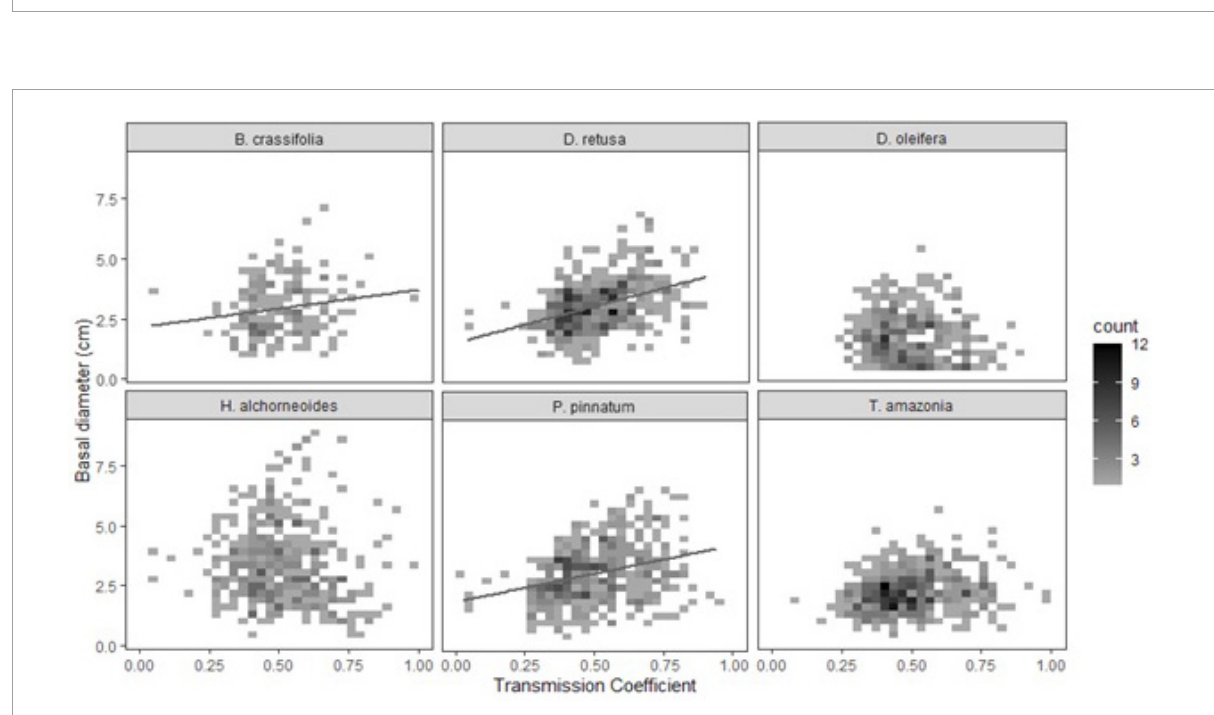
FIGURE3 Effect of crowding pressure from teak on seedling growth (30-month basal diameter, cm) for each of the six enrichment planting species. Basal diameter values are plot-level means ( n = 12 seedlings). Crowding pressure values are for one target seedling per plot. There were significant, negative relationships ( P < 0.05) for all species except for D. oleifera .